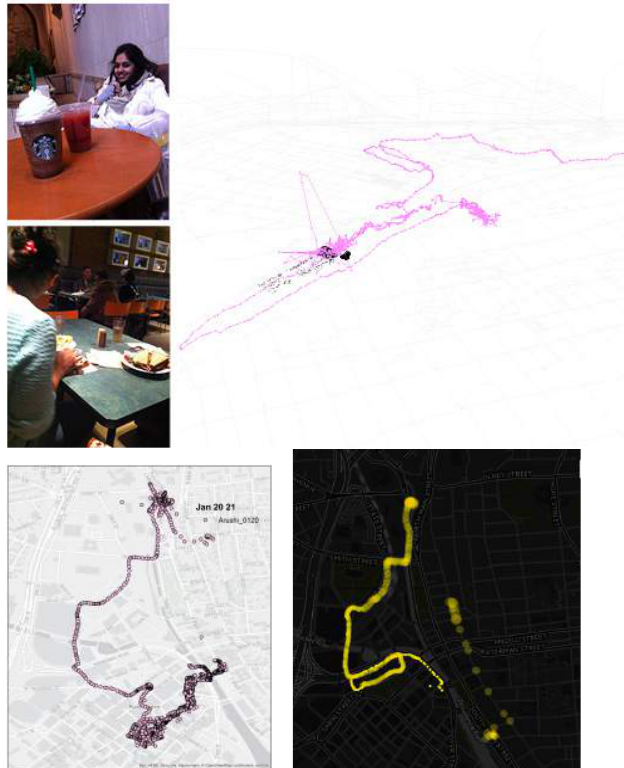
Figure 10 : Typical images from Arushi’s tracking, in which friends figure prominently. Her tracks typically double back on themselves, indicating less regard for efficiency. Each rendering – in Rhino, in Open Street Maps, and as an animated trajectory - tells a different version of the same story, based on trajectory, frequency, duration and clustering